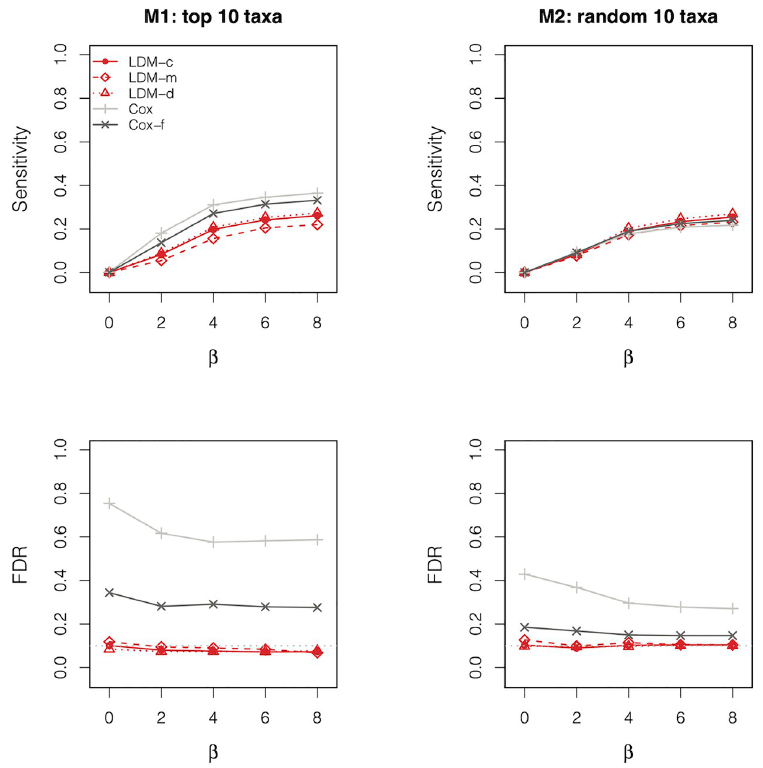
Fig 1. Sensitivity and empirical FDR of the taxon-specific tests in analysis of simulated data with a confounder X i ( β XZ = 0.8), 50% censoring, and n = 100. “Cox-f” is the Firth-corrected Cox model. The gray dotted line represents the nominal FDR level